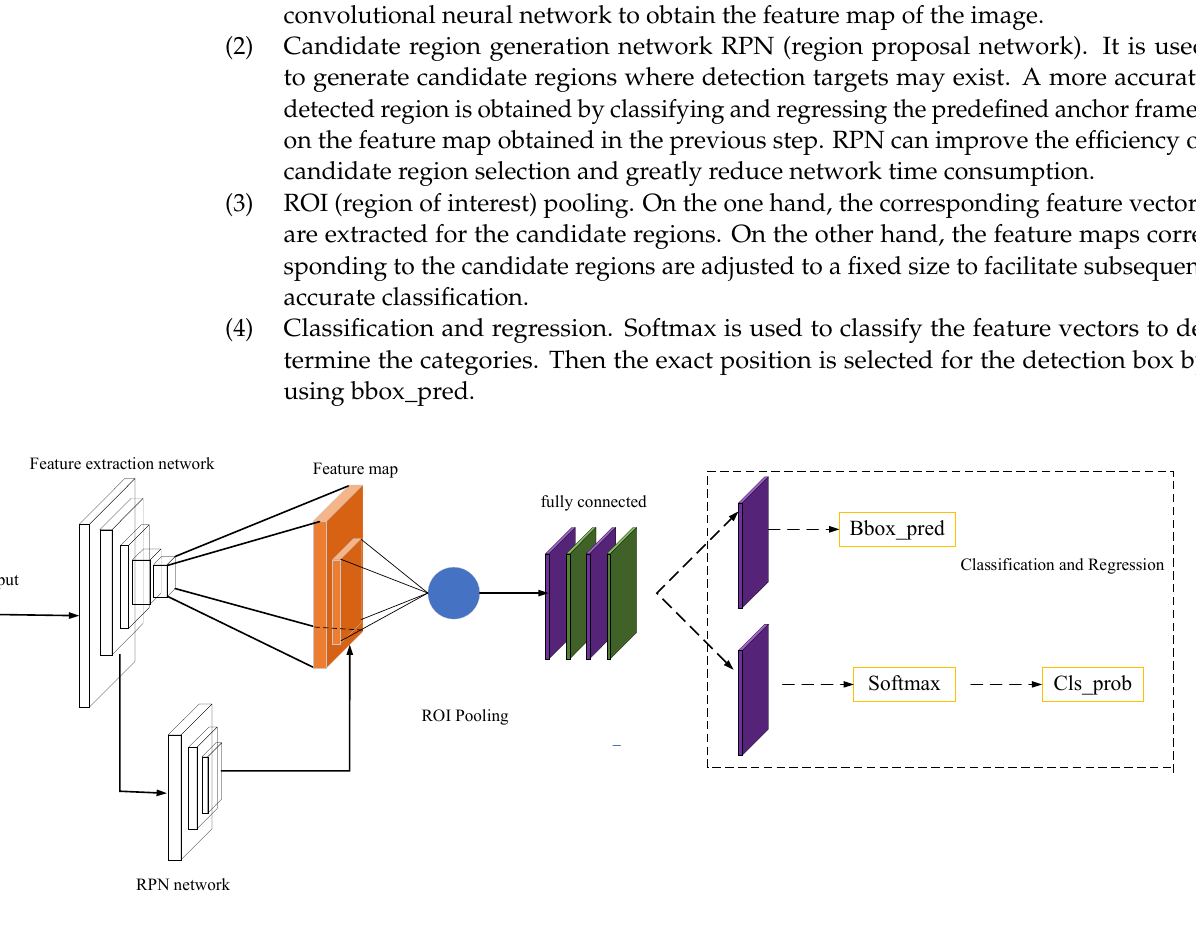
Figure 1. Faster R-CNN network framework diagram.